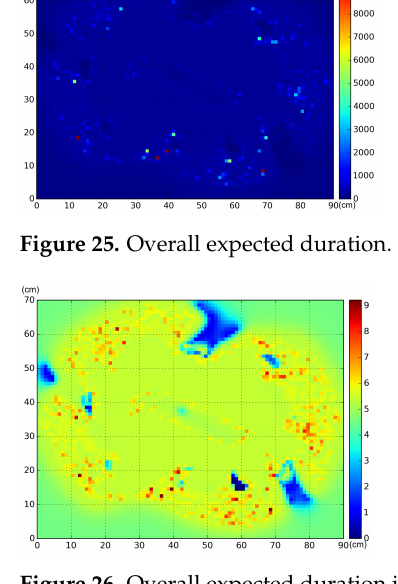
Figure 26. Overall expected duration in log